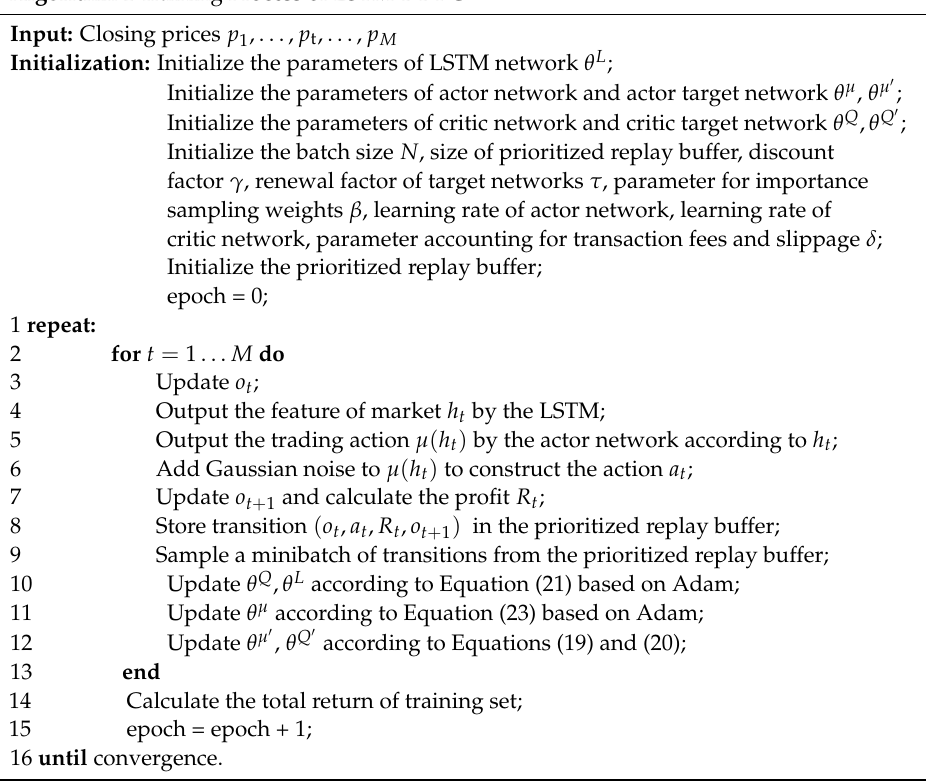
Algorithm 1 Training Process of